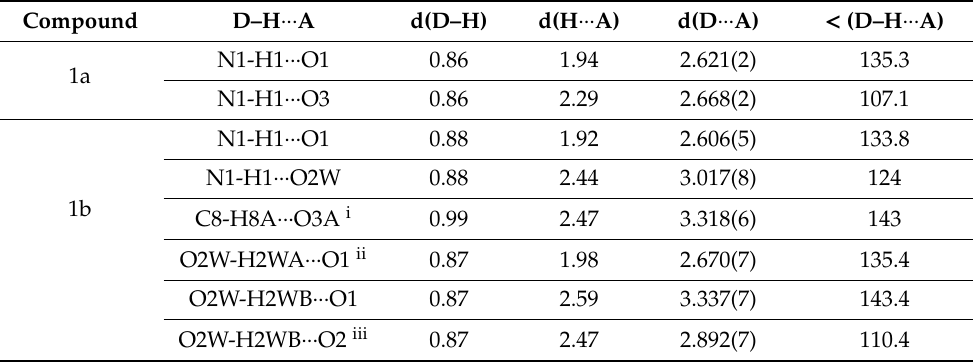
Table 2. Hydrogen bonding geometry (Å, ◦ ) for structures 1a and 1b